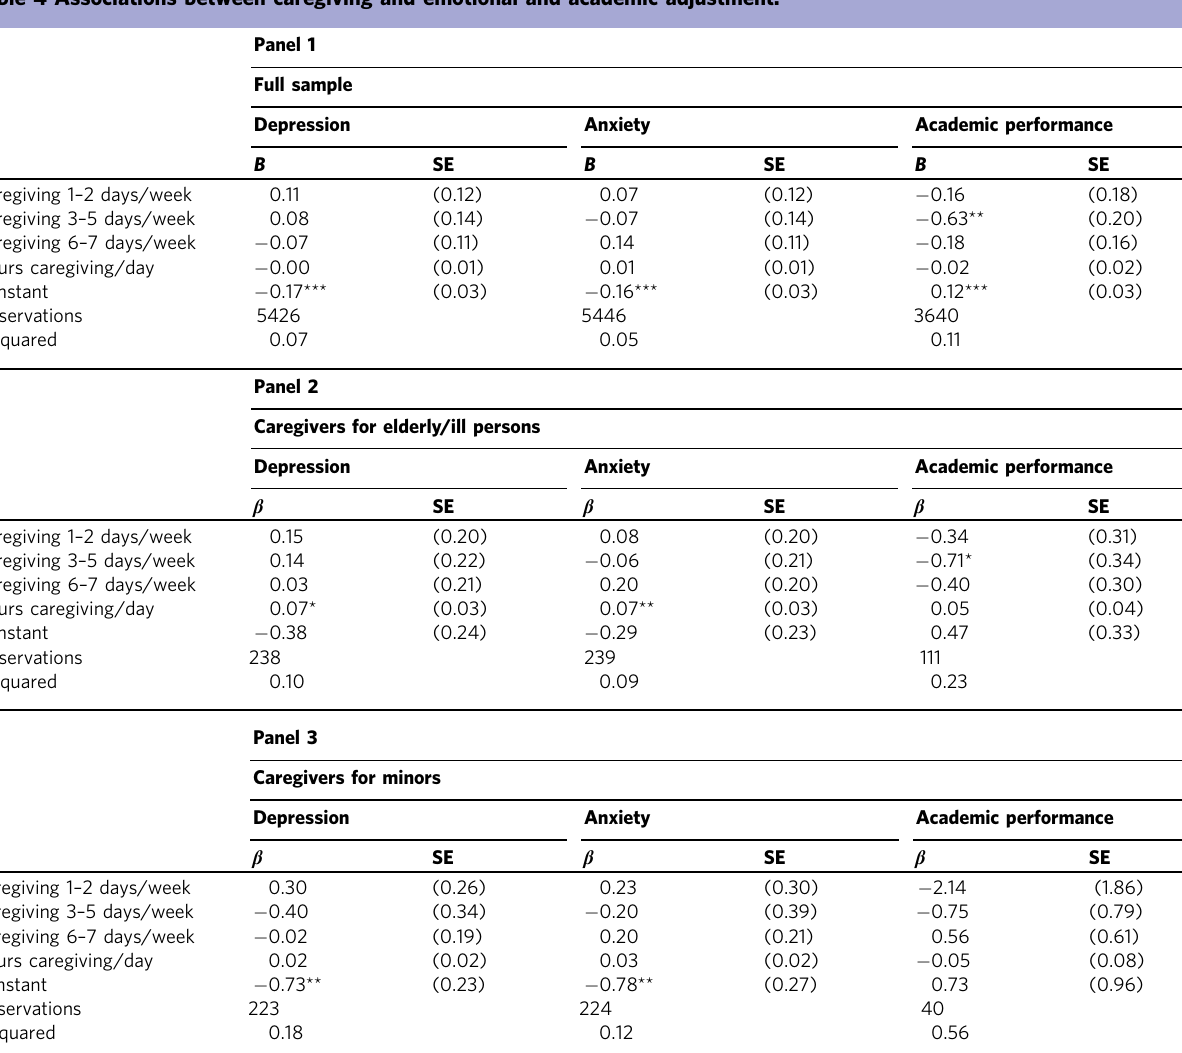
Table 4 Associations between caregiving and emotional and academic